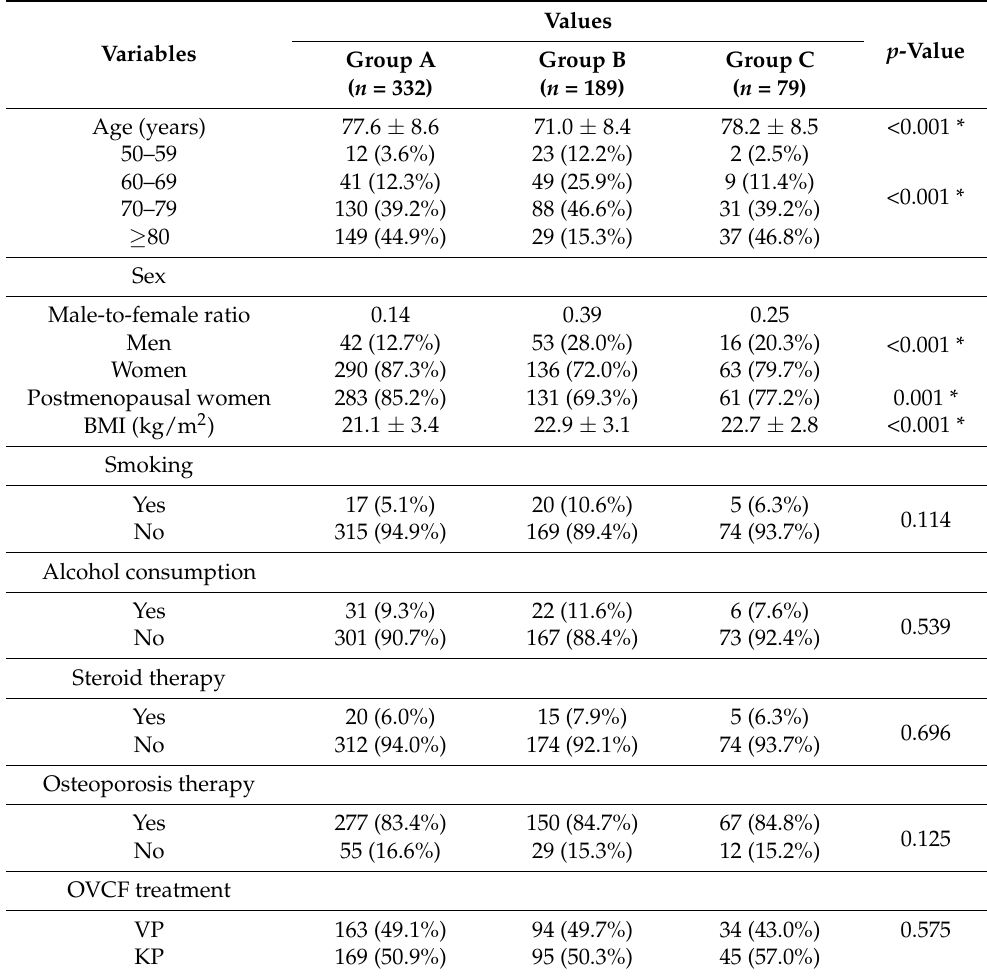
Table 2. Differences in baseline characteristics of the patients between the three groups ( n =